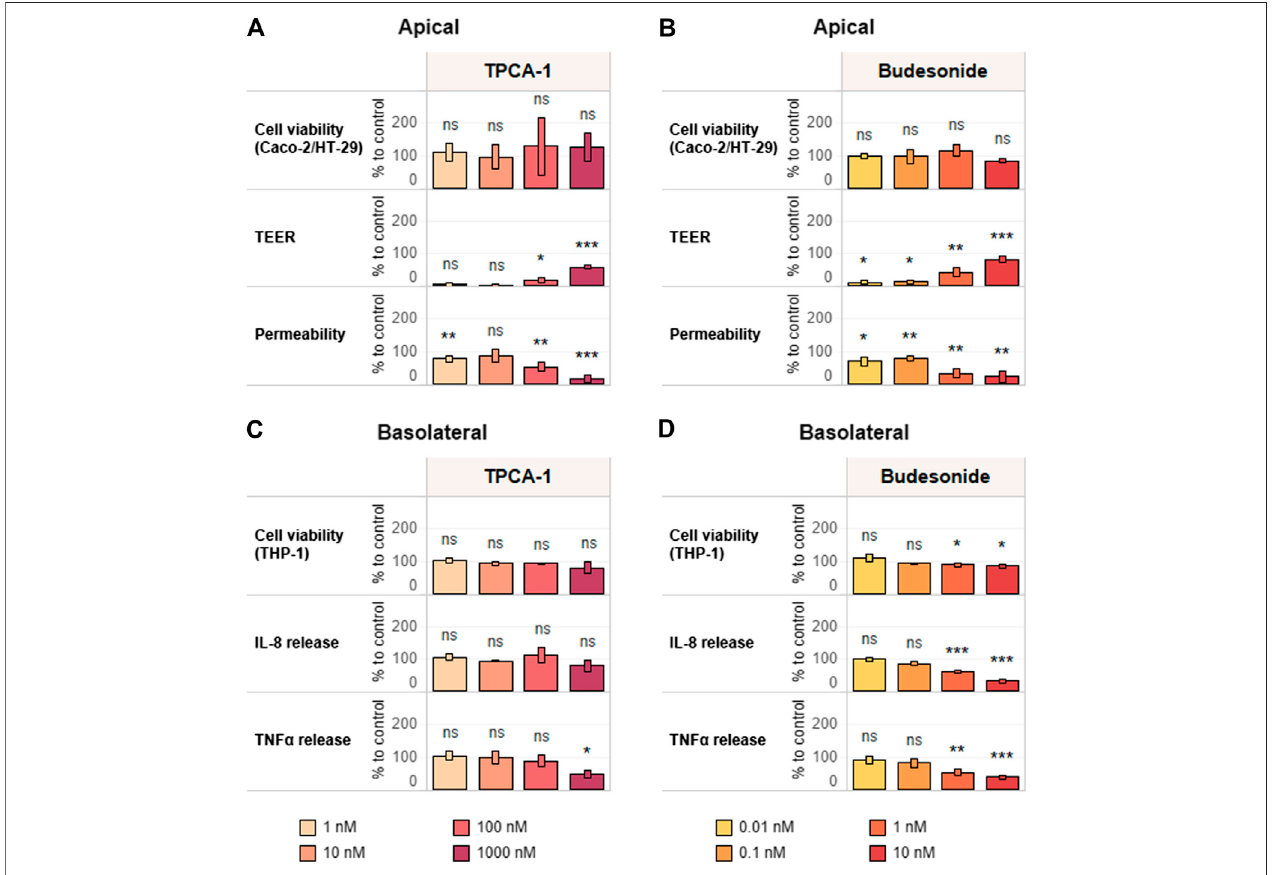
FIGURE 5 | Reference item assessment and veri fi cation of the anti-in fl ammatory protocol. Tricultures were treated basolaterally with increasing concentrations of (A,C) TPCA-1 and (B,D) budesonide for 6 h and subsequently stimulated with 10 ng/ml LPS for 18 h. TEER, epithelial layer permeability, cell viability of differentiated Caco-2/HT29-MTX cells (A,B) and cytokine release and cell viability of differentiated THP-1 cells (C,D) were measured. TEER values are normalized to control (CTL; 100%) and LPS treatment (0%). Permeability is normalized by using LPS treatment as reference (100%). Basolateral IL-8 and TNF α release are expressed as percentage of control (cells treated with LPS only; CTL; 100%). Cell viability values of Caco-2-HT29-MTX cocultures and THP-1 cells are expressed as percentage of control (cells treated with LPS only, CTL; 100%). n (cid:2) 3 independent experiments. Statistical differences between reference compound-treated vs. LPS-treated-only cultures were determined by a two-tailed t -test. * p ≤ 0.05; ** p ≤ 0.01; *** p ≤ 0.001; ns, p > 0.05. Abbreviations: LPS, lipopolysaccharide; TEER, transepithelial electrical resistance; TNF, tumor necrosis factor; IL,